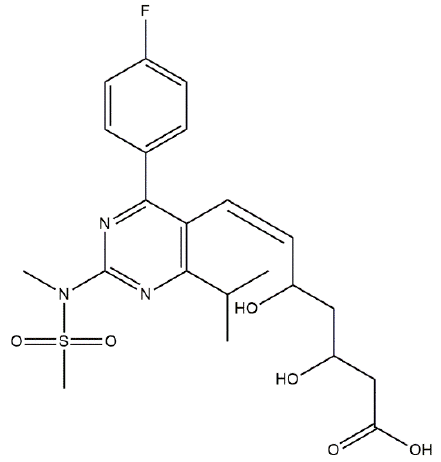
Figure 4. Schematic representation of the chemical structure of rosuvastatin (RVS).